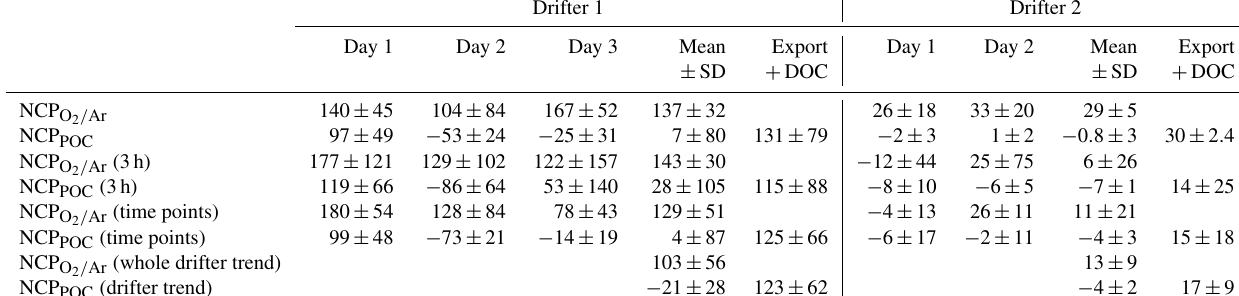
Table 2. Comparisons of NCP calculated using four different timescales of integration: (rows 1–2) day and night linear regressions, (rows 3– 4) summed linear regressions over 3h increments, (rows 5–6) the difference between two time points every 24h, and (rows 7–8) a single linear regression over the entire drifter period. Refer to Sect. 2.6.3 for further details. For every calculation approach, “Export + DOC” is the average difference between NCP O and NCP POC values ± 1SD or ± the propagated error. All units here are in millimoles of carbon per 2 / Ar square meter per day (mmolCm − 2 d − 1 ).